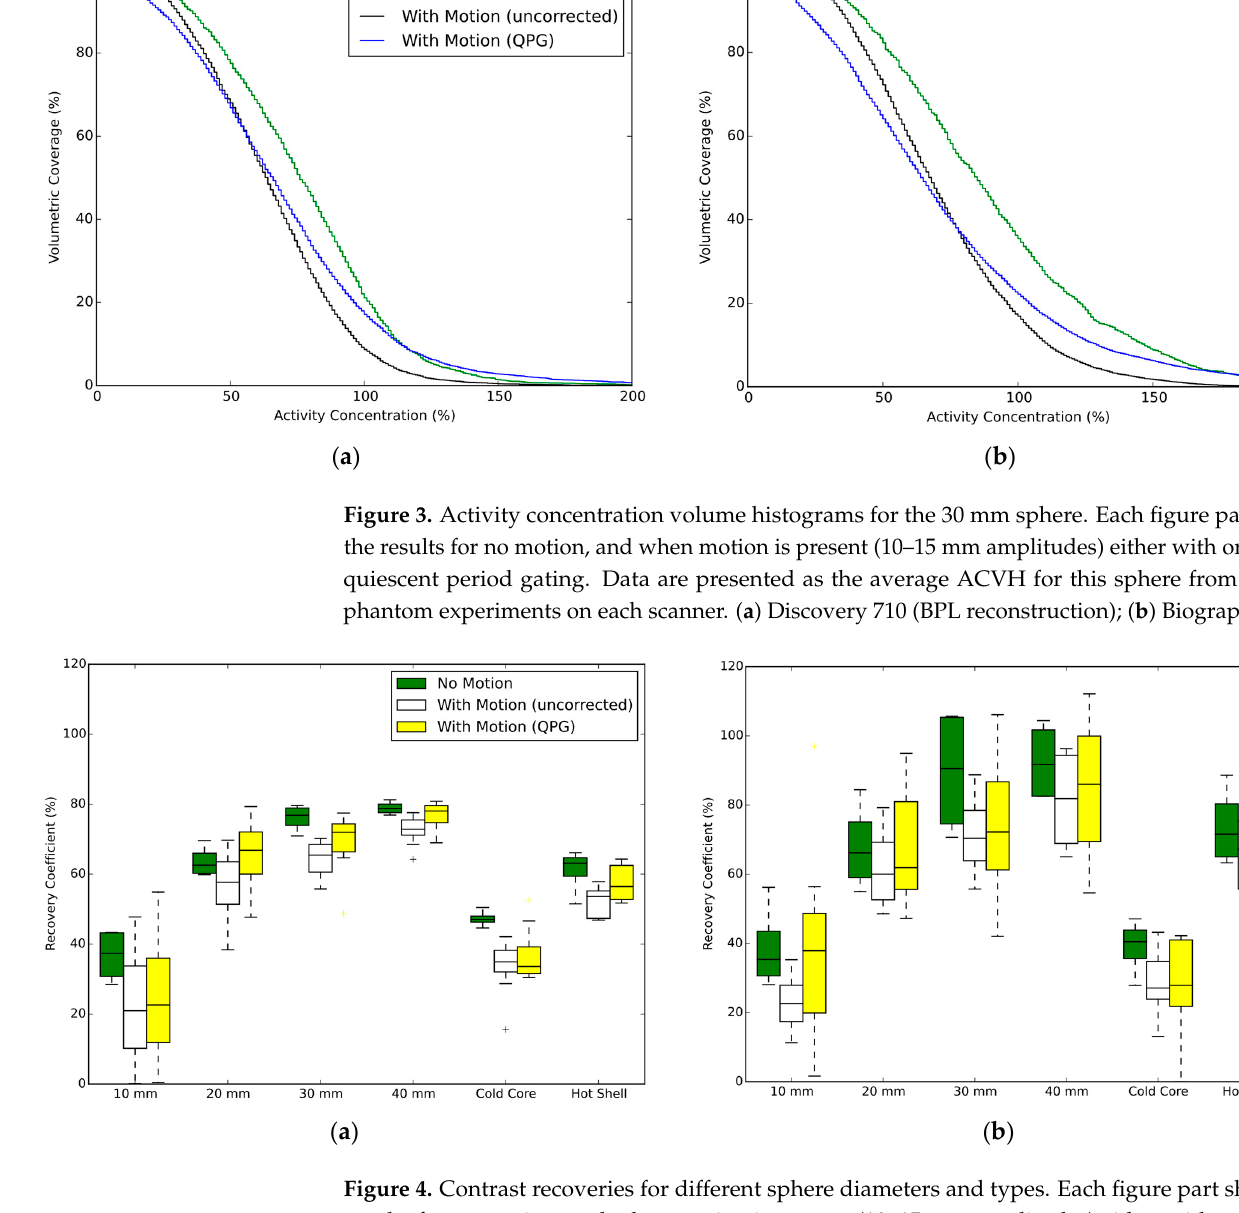
Figure 4. Contrast recoveries for different sphere diameters and types. Each figure part shows the results for no motion, and when motion is present (10–15 mm amplitudes) either with or without quiescent period gating. Combined datasets from four phantom experiments on each scanner. ( a ) Discovery 710 (BPL reconstruction); ( b ) Biograph mCT.